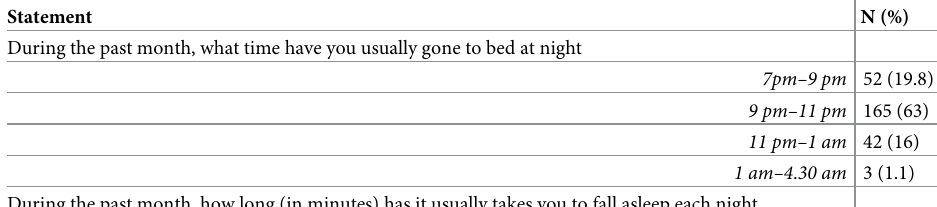
Table 3. Responses on PSQI by respondents on Urdu PSQI questionnaire (n =